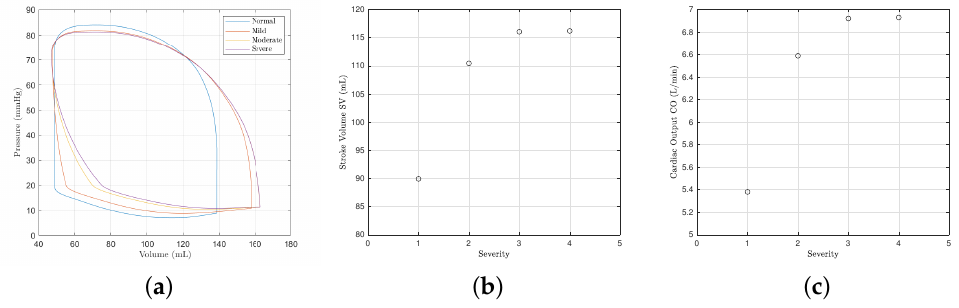
Figure 6. Left ventricle pressure–volume loop, the stroke volume and the cardiac output with different severities of aortic valve regurgitation. The x axis of the SV and CO figures give the severity of regurgition, where 1 denotes normal or control, 2 denotes mild, 3 denotes moderate, and 4 denotes severe. The parameter values used to model each severity are provided in Table